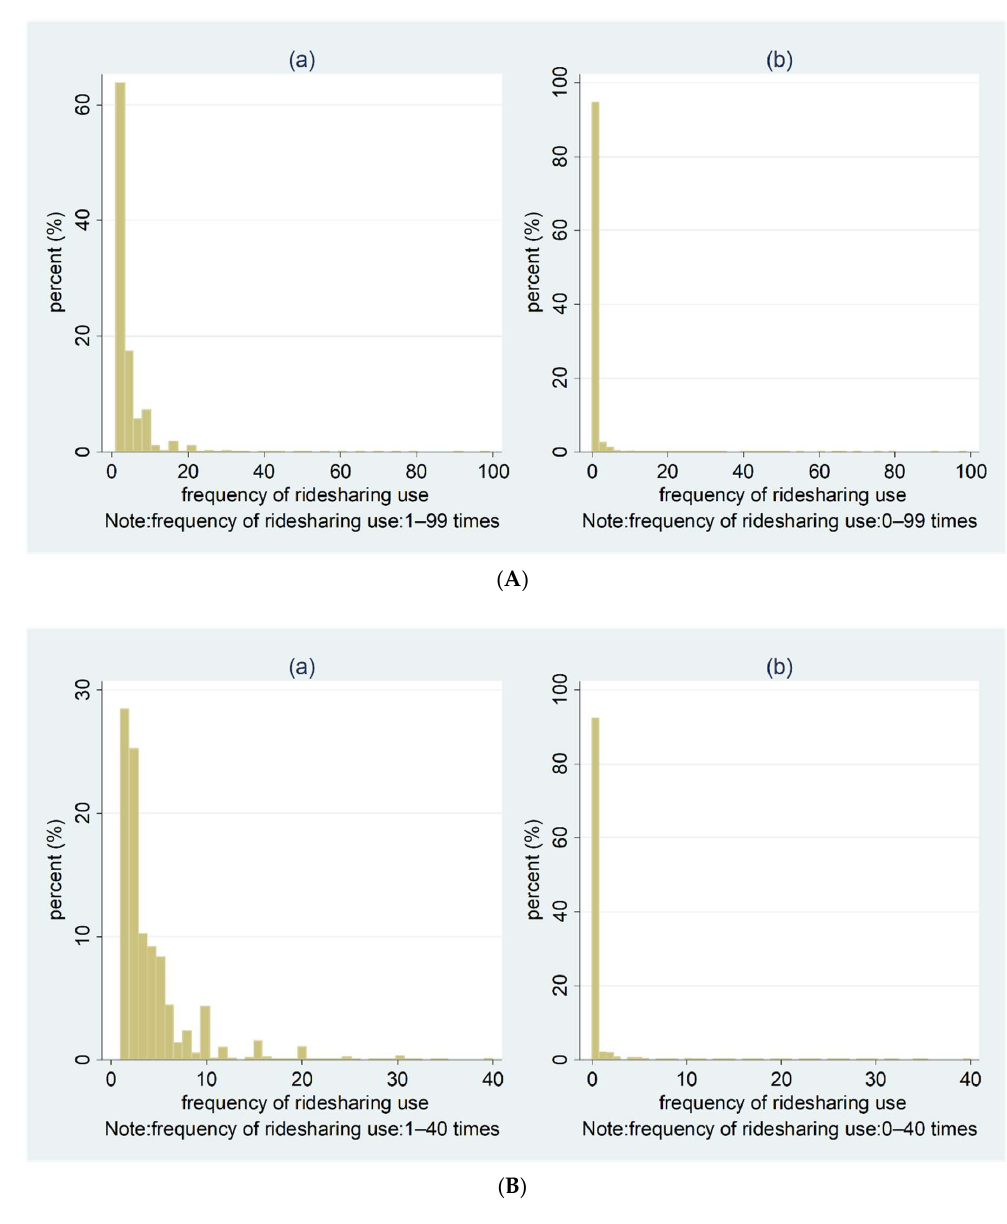
Figure 1. ( A ) Distribution of the frequency of monthly ridesharing use for those who used ridesharing in the past 30 days: ( a ) 1–99 times; ( b ) 0–99 times. ( B ) Distribution of the frequency of monthly ridesharing use for those who used ridesharing in the past 30 days: ( a ) 1–40 times; ( b ) 0–40 times.